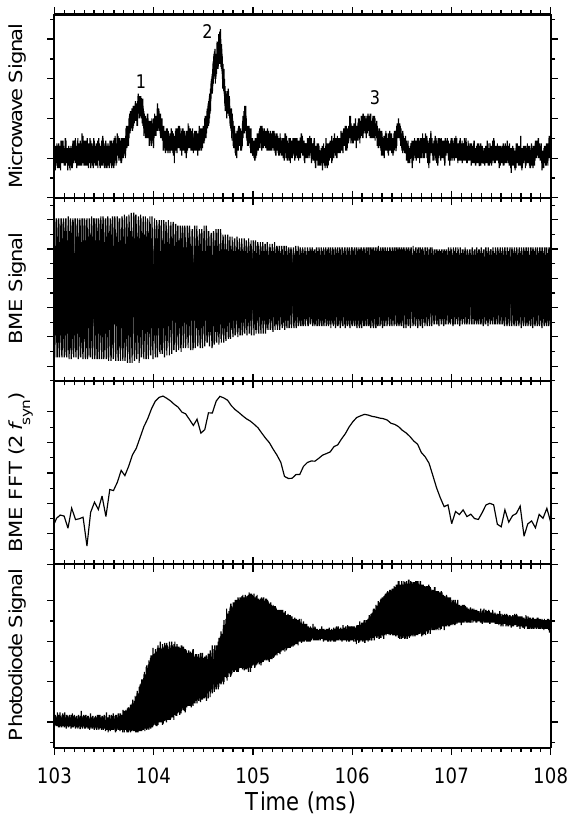
FIG. 2. Top: microwave signal; second: BME signal; third: Fourier transform of BME signal, centered on 2 f syn ; bottom: photodiode signal. The data were collected at E 0 (cid:1) 255.9 MeV, I B (cid:1) 90 mA, V rf (cid:1) 10.8 kV, and f rf (cid:1) 34.5 ± . The top signal shows that there is a main microwave burst (peak 2: FWHM 0.12 ms) and two dominant smaller peaks (peak 1: delay D t (cid:1) 2 0.8 ms, FWHM 0.15 ms; peak 3: D t (cid:1) 1.5 ms, FWHM 0.36 ms). These bursts are clearly correlated with the amplitude of the quadrupole synchrotron sideband in the BME spectrum (see also Fig. 3) and features in the photodiode signal. The signal levels are omitted because they are not meaningful, since they depend strongly on the collection electronics.